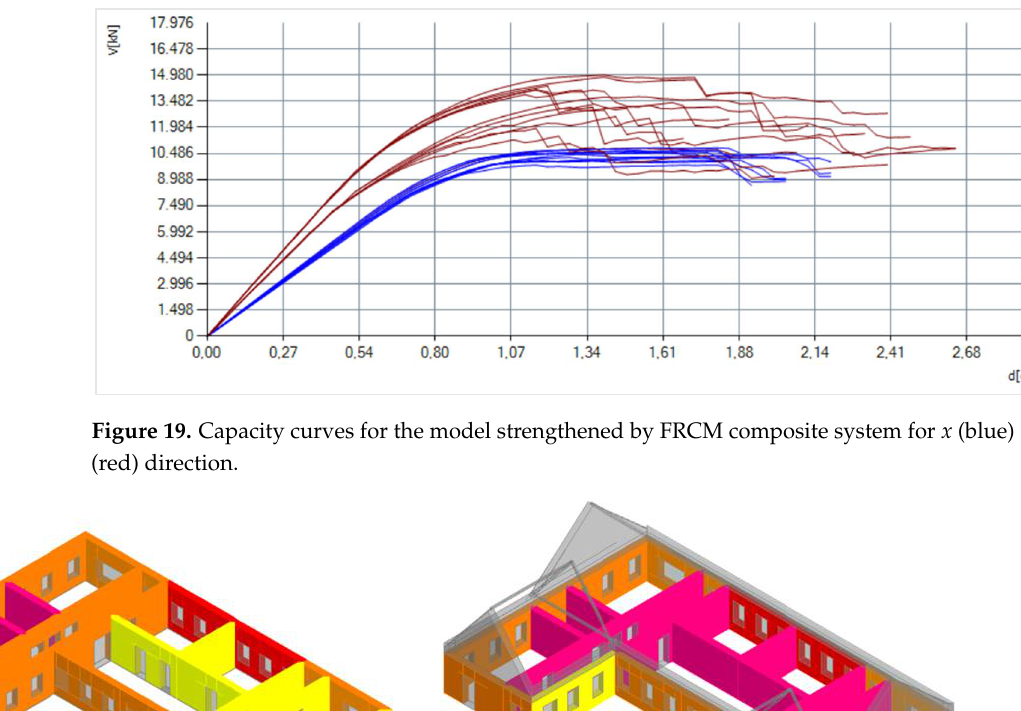
Figure 21. Capacity curves for the model strengthened by FRP composite system for x (blue) and y (red) direction. 3.2.3. Reinforcement with Concrete Shotcrete The third and final analyzed method is reinforcement with shotcrete. The thickness of the concrete layer is 6 cm, the selected reinforcing mesh is Q283 (6 mm diameter bars with 100 mm pitch), and the steel grade is B500B. Unlike the previous two strengthening methods, shotcrete is applied to only one face of the wall, given that such a variant meets the required checks, and results in a lower cost of reconstruction. On the external walls, shotcrete is applied on the inner face of the wall to preserve the appearance of the build- ing, which has great cultural and historic importance. The most favorable configuration of shotcrete reinforcement that satisfied the Significant Damage and Limited Damage limit states (Figure 22) was determined by iteration. The results of the pushover analyses are presented as 24 capacity curves (Figure 23).